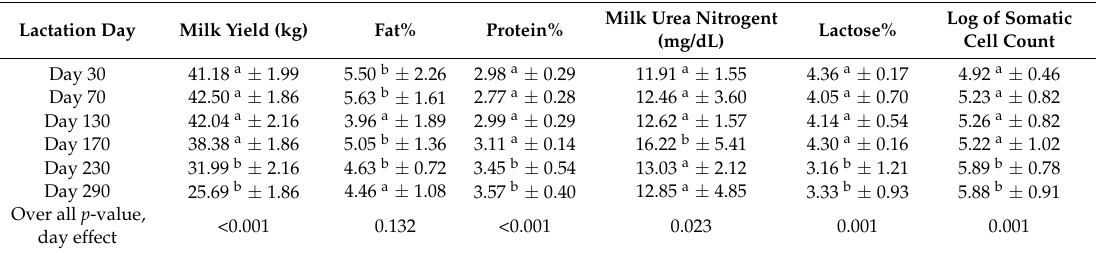
Table 1. Milk and component yields (mean ± standard deviation) throughout the lactation curve. For each trait, data for each day was compared with day 30.